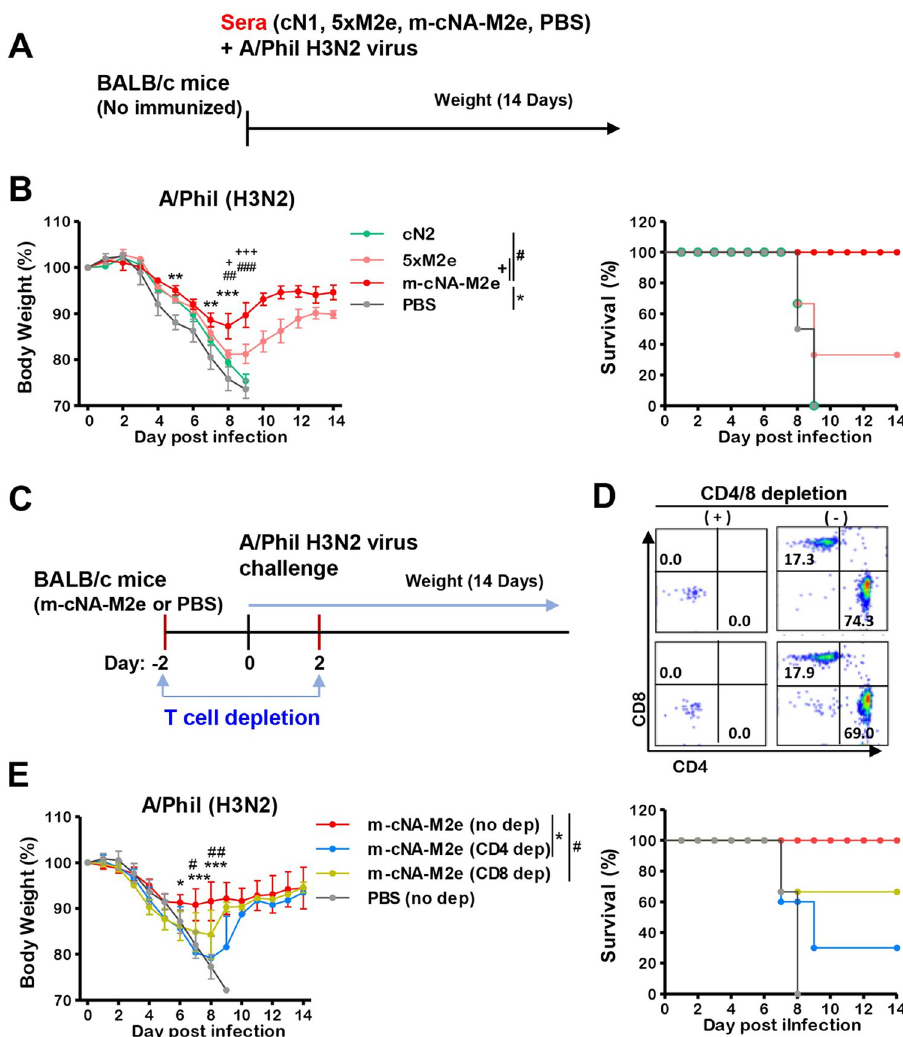
Fig 8. The roles of immune sera and T cell responses in conferring protection. (A) Experiment schematic diagram to determine the roles of immune sera. Na ï ve mice (n = 3 per group) were intranasally infected with a mixture of influenza virus A/Phil H3N2 (4 × LD 50 , 3.7x10 2 EID 50 ) and immune sera from the m-cNA-M2e VLP, 5 × M2e VLP, cN2 VLP, or na ï ve control groups. (B) Weight changes and survival rates for 14 days. ( C-D ) Contribution of T cells to protection in m-cNA-M2e VLP vaccinated mice. The statistical significances are indicated as � ,#,+ , P < 0.05; �� ,## , P < 0.01; ��� ,###,+++ , P < 0.001 and bars mark the comparing groups. ( C ) Experiment schematic diagram to determine the roles of T cells. ( D ) Flow profiles to represent the depletion efficacy of CD4 T cells and CD8 T cells in m-cNA-M2e VLP vaccinated mice (n = 4 per group) by intraperitoneal injection with anti-CD4 (clone GK1.5) or anti-CD8 (clone 53.6.7) antibodies. (E) Weight changes and survival rates for 14 days in m-cNA-M2e VLP vaccinated mice with or without T cell depletion after challenge with A/Phil H3N2 virus (4 × LD 50 , 3.7x10 2 EID 50 ). The statistical significances are indicated as � ,#,+ , P < 0.05; �� ,## , P < 0.01; ��� ,###,+++ , P < 0.001 and bars mark the comparing